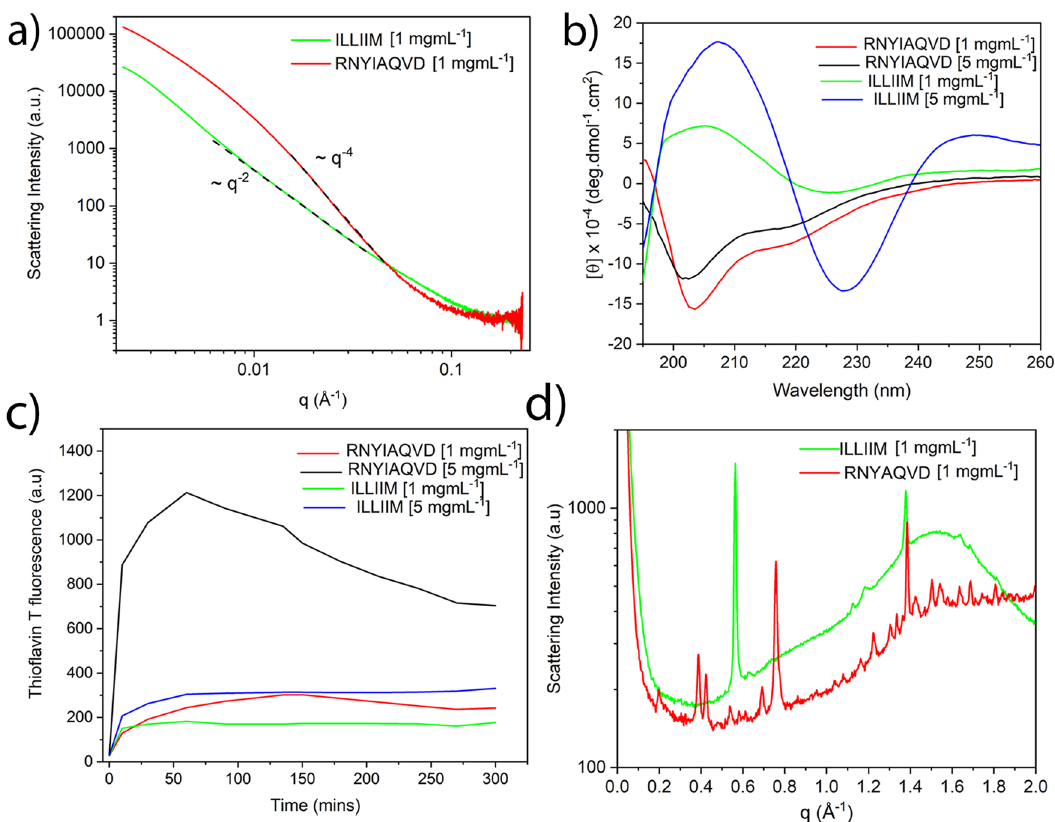
Fig. 3 Spectroscopic analysis of the secondary structure of the peptide assemblies. a 1D SAXS plots showing q − 2 dependence for ILLIIM ( fl at ribbon) and q − 4 dependence for RNYIAQVD, b circular dichroism spectroscopy of the two peptide assemblies and c Thio fl avin T spectroscopy to quantify the amount of amyloid formation of the two peptide assemblies. d WAXS spectra of ILLIIM and RNYIAQVD assemblies. SAXS and WAXS plots are shown as background subtracted against PBS in the same quartz capillary and averaged from approximately 15 recorded